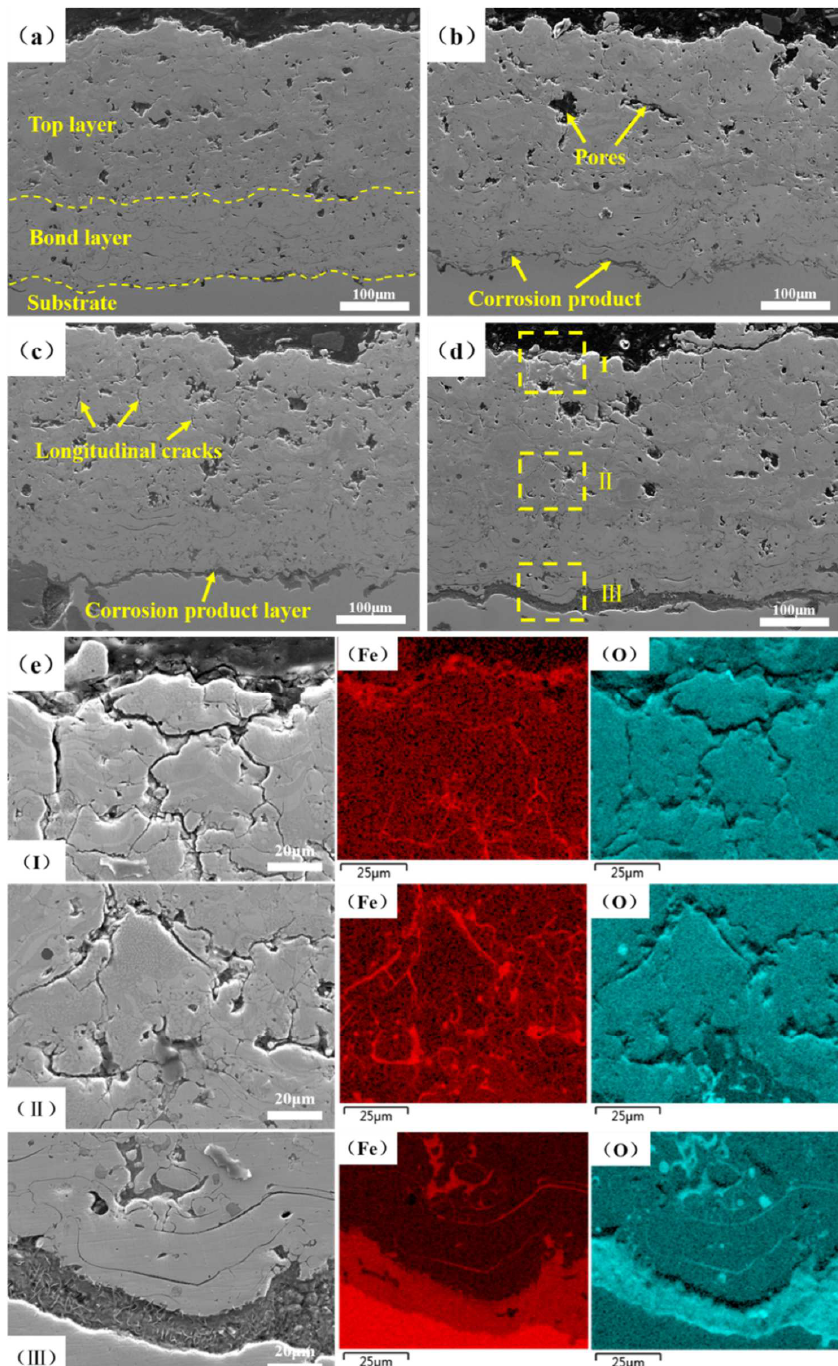
Figure 6. Cross-sectional SEM images and EDS of NiCoCrAlY/MSZ coatings: ( a ) N-0; ( b ) N-2; ( c ) N-4; ( d ) N-6; ( e ) composition distribution in different zones of N-6: ( Ι ) top of the TC, ( Ⅱ ) interface between the TC and BC, ( Ⅲ ) interface between the BC and substrate.